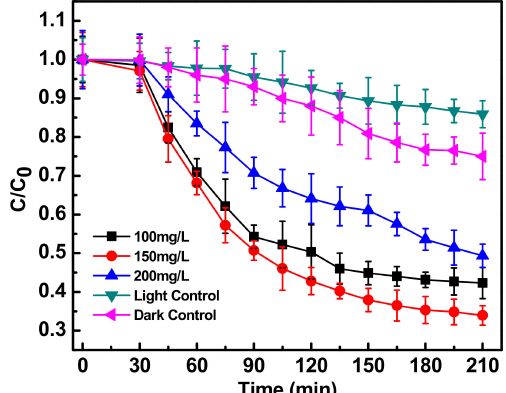
Figure 2. Photocatalytic degradation of antibiotic ciprofloxacin (10 mg/L) in water, in the presence of Fe-ZnO nanoparticles (at different concentrations of 100, 150 and 200 mg/L) irradiated with sunlight light intensity of 80,000 ± 3000 lux compared to photolysis (light control) and degradation in the absence of light (dark control). C 0 represents initial concentration of ciprofloxacin and C represents concentration of ciprofloxacin at a particular time point. C/C 0 denotes the time dependent change in ciprofloxacin concentration with respect to initial